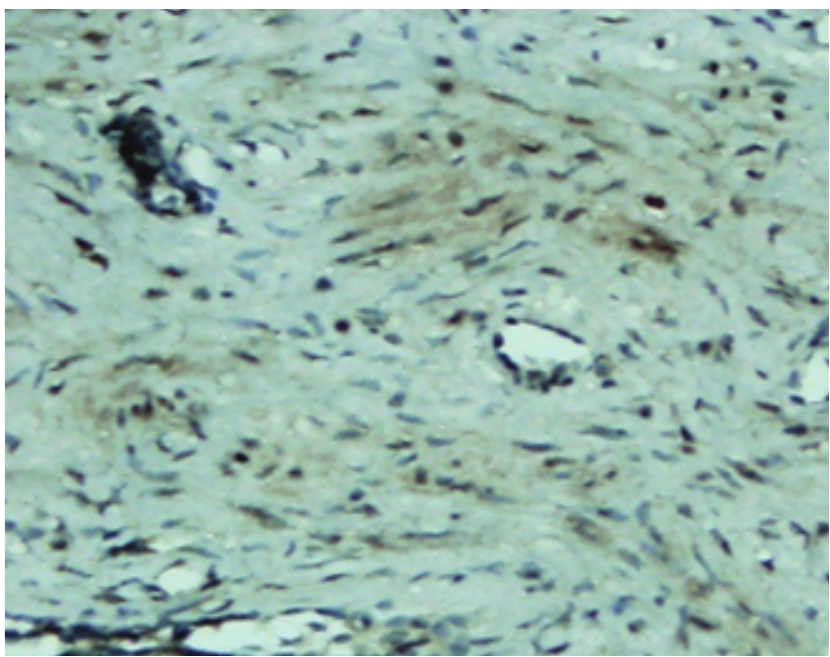
Figure 3: Prostatic adenocarcinoma, showing moderate nuclear Cyclin D1 staining, grade 2+.